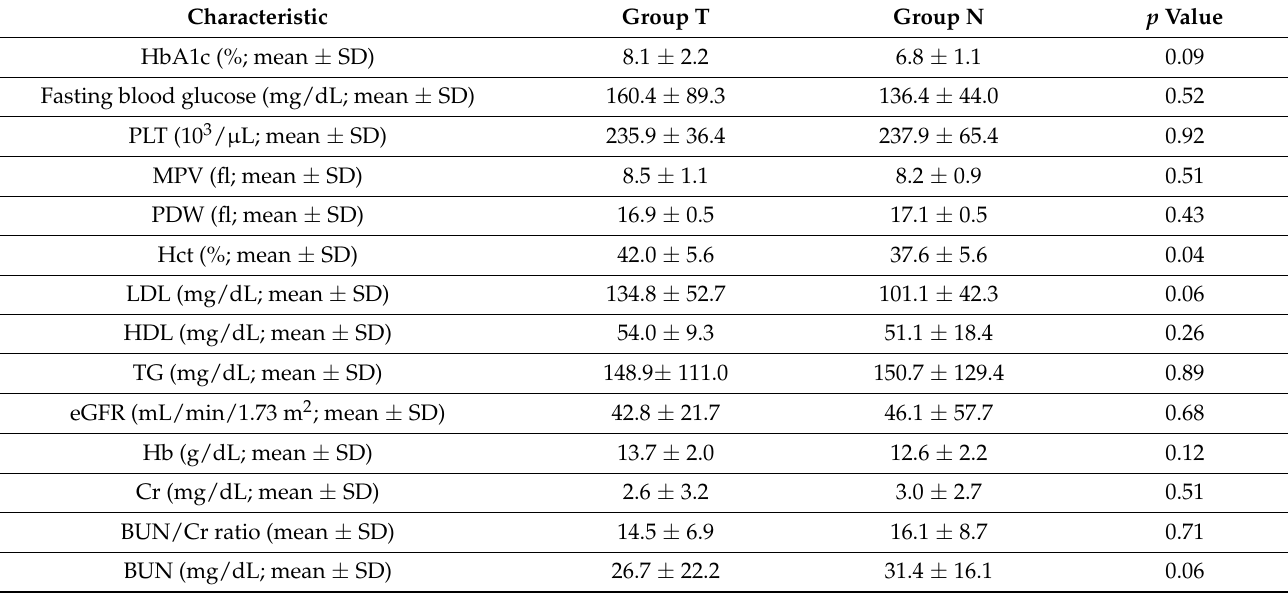
Table 2. Comparisons of clinical characteristics between group T and group N.